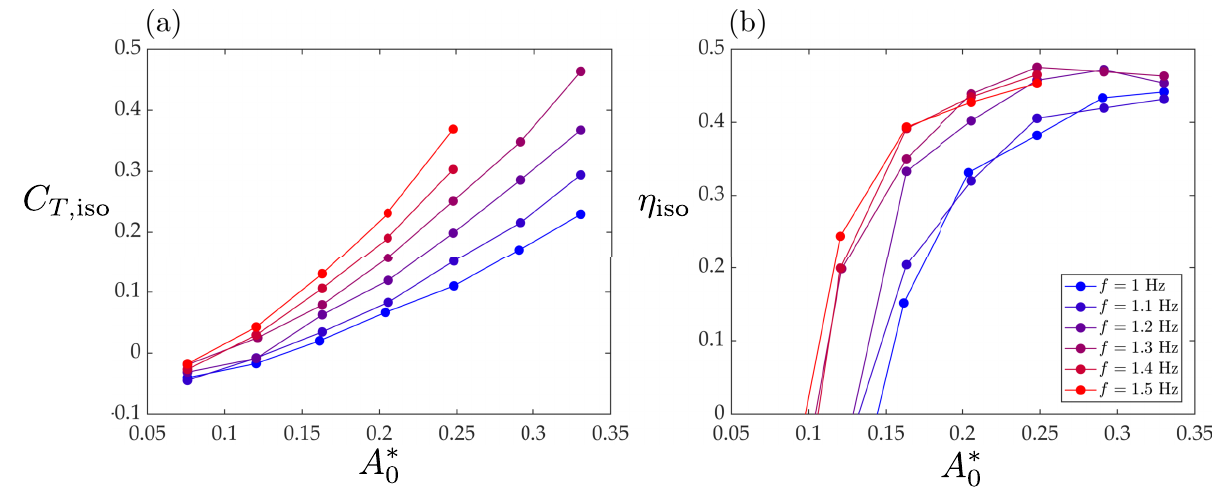
Figure 3. ( a ) Thrust coefficient and ( b ) efficiency as a function of the dimensionless amplitude, A ∗ frequencies, f . The lowest to the highest frequencies within the range of 1 ≤ f ≤ 1.5 are mapped from blue to red.